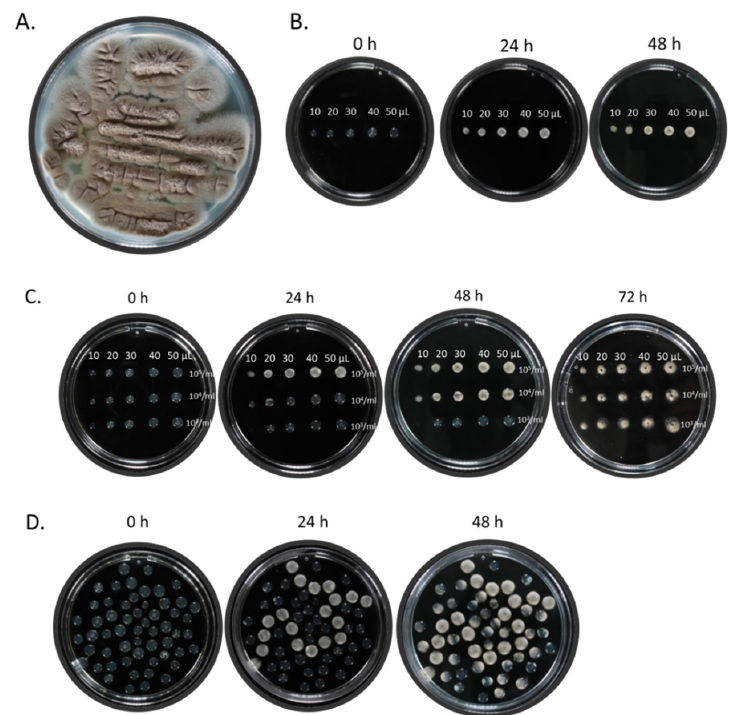
Figure 1. Calibration of the fungal dot painting technique. ( A ) A. nidulans strain R153 was grown on YAG agar for 48 h at 37 °C, and conidia were collected and counted. ( B ) 10 5 conidia/mL were suspended in molten YAG agar at 50–55 °C, point inoculated at 10–50 µL agar volume on the plastic surface of a Petri dish and incubated for up to 48 h at 37 °C. ( C ) 10 3 –10 5 conidia/mL were suspended in molten YAG agar at 50–55 °C, point inoculated at 10–50 µL agar volume on the plastic surface of a Petri dish and incubated for up to 72 h at 37 °C. ( D ) Conidia were suspended in molten YAG agar at 50–55 °C, point inoculated at either 50 µL agar volume at a concentration of 10 5 conidia/mL to generate the curved line or at 30 µL agar volume at a concentration of 10 3 conidia/mL to generate the background.